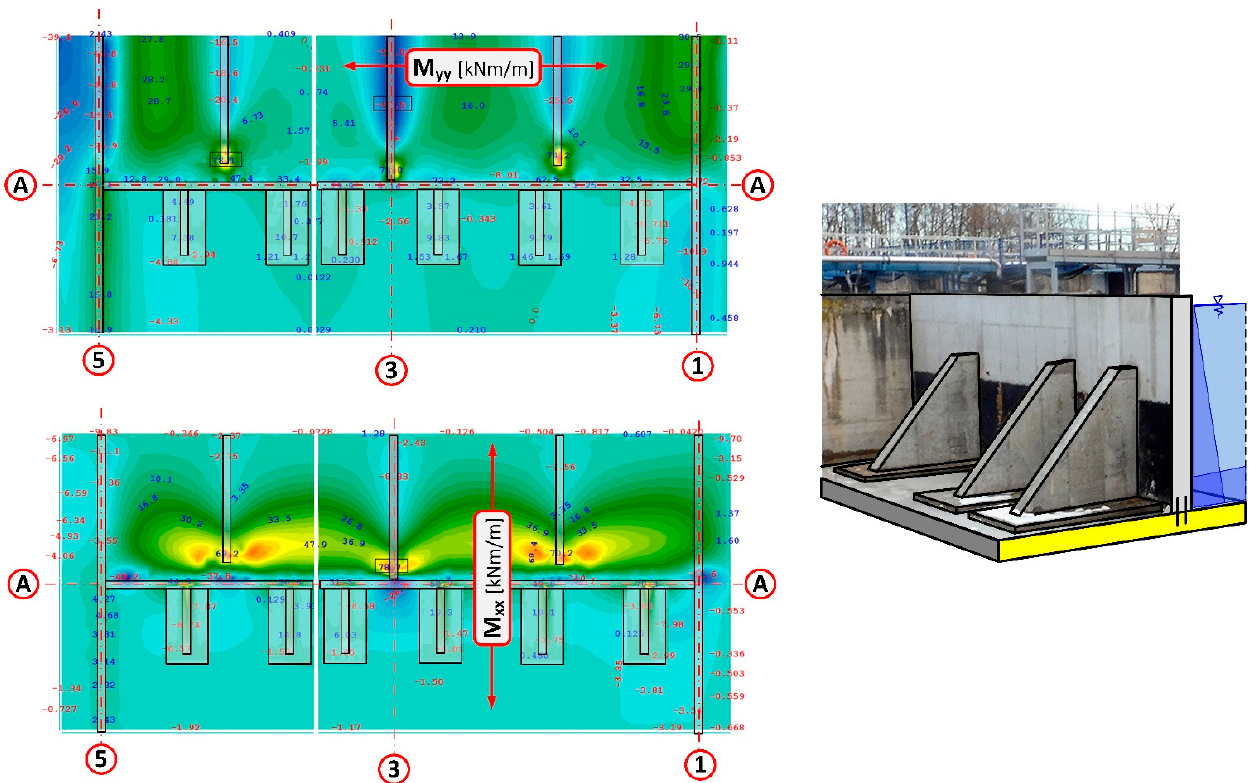
Figure 21. Values of the calculated moments for the foundation slab during the leak test together with the location of the walls and pilasters supporting the wall.